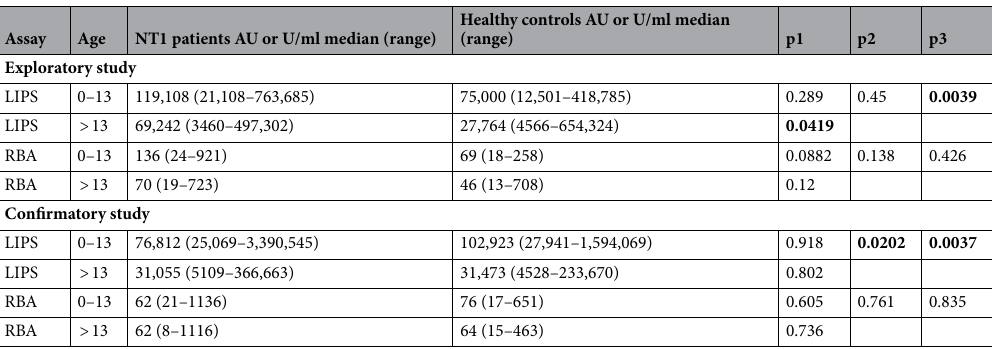
Table 1. A/H1N1 HA antibody levels in relation to age. LIPS and RBA results are reported according to age groups: childhood patients (exploratory study, n = 11; confirmatory study, n = 11), childhood controls (exploratory study, n = 21; confirmatory study, n = 10), adult patients (exploratory study n = 32; confirmatory study, n = 20), adult controls (exploratory study, n = 43; confirmatory study, n = 44). AU and U/ml are referred to LIPS and RBA results, respectively. Indicated p-values refer to Mann–Whitney U tests comparing A/H1N1 HA antibodies levels between: patients and age-matched controls (p1), narcolepsy childhood and adolescent/ adult patients (p2), healthy childhood and adolescent/adult controls (p3).